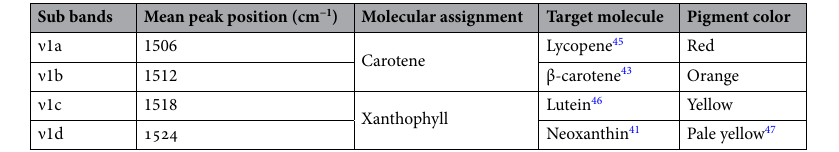
Table 1. Molecular assignment for the deconvoluted